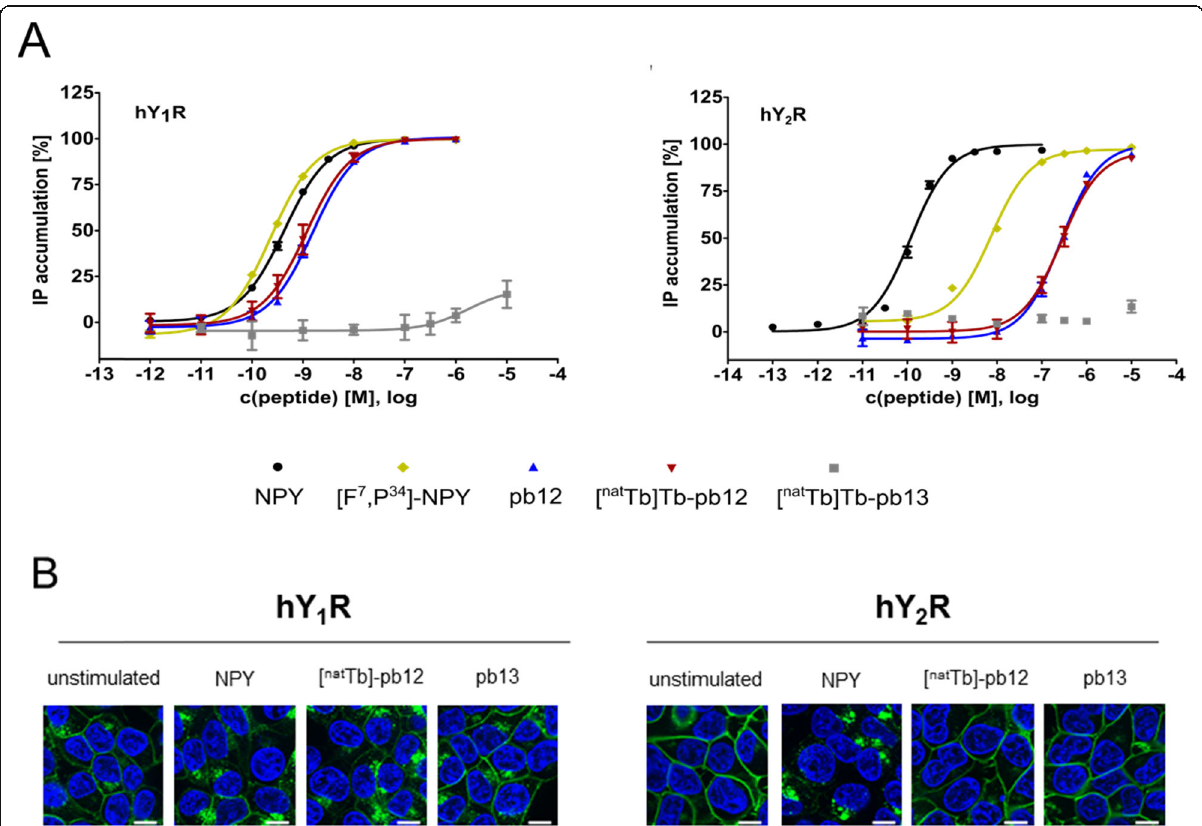
Fig. 4. a NPY receptor activation profile by measurement of IP accumulation upon stimulation of the hY 1 R and hY 2 R with NPY conjugates NPY, [F 7 ,P 34 ]-NPY, pb12, [ nat Tb]Tb-pb12, and [ nat Tb]Tb-pb13. b Receptor internalization studies on HEK293 cells stably expressing the hY 1 R or hY 2 R fused to eYFP (green) following stimulation with [ nat Tb]Tb-pb12 and pb13. Scale bar = 10 μ